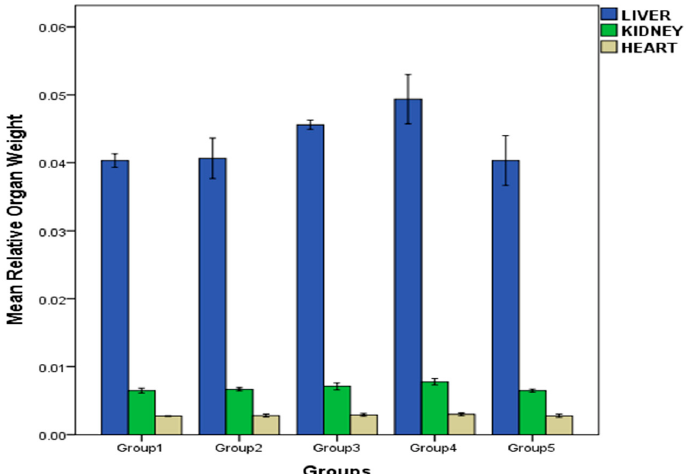
Figure 4. Effect of repeated oral administration of P. dactylifera seed essential oil on relative organ weight of Wistar rats. weight of Wistar